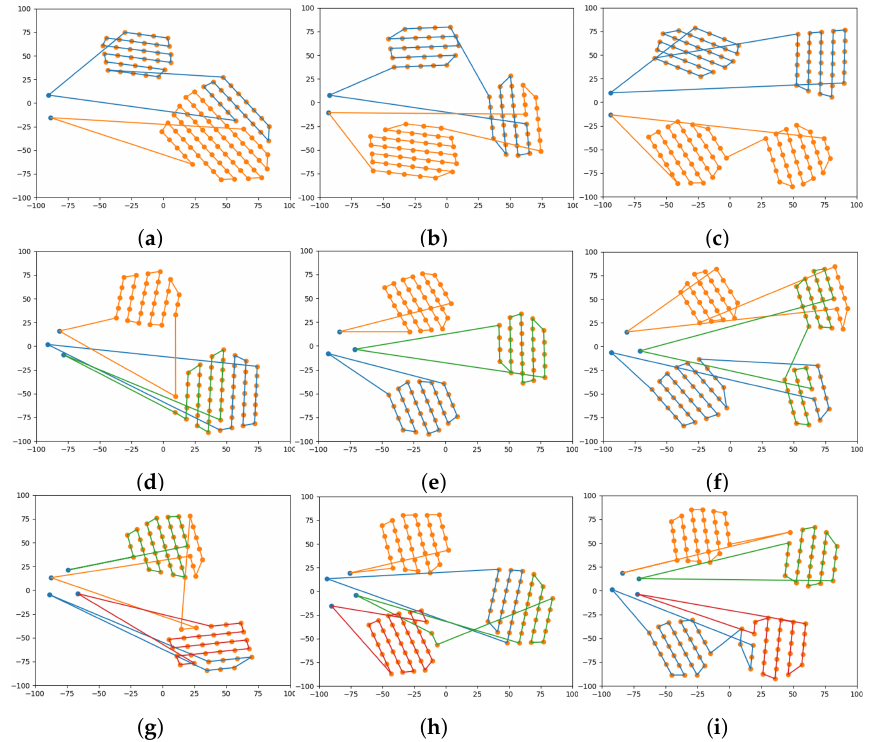
Figure 8. Results of the path-planning system for multiple UAVs and multiple areas: ( a ) two UAVs and two areas; ( b ) two UAVs and three areas; ( c ) two UAVs and four areas; ( d ) three UAVs and two areas; ( e ) three UAVs and three areas; ( f ) three UAVs and four areas; ( g ) four UAVs and two areas; ( h ) four UAVs and three areas; ( i ) four UAVs and four